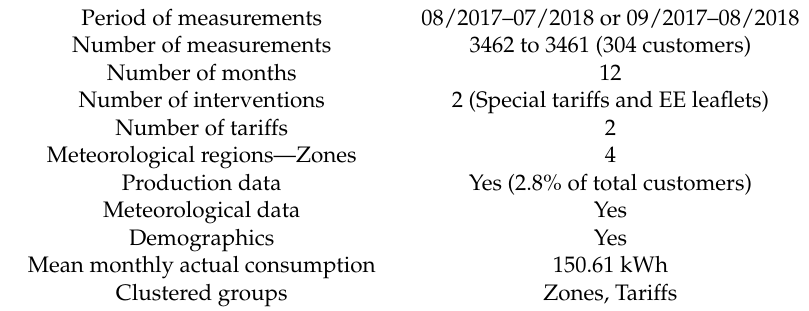
Table 4. Highlights of ENOSTRA’s